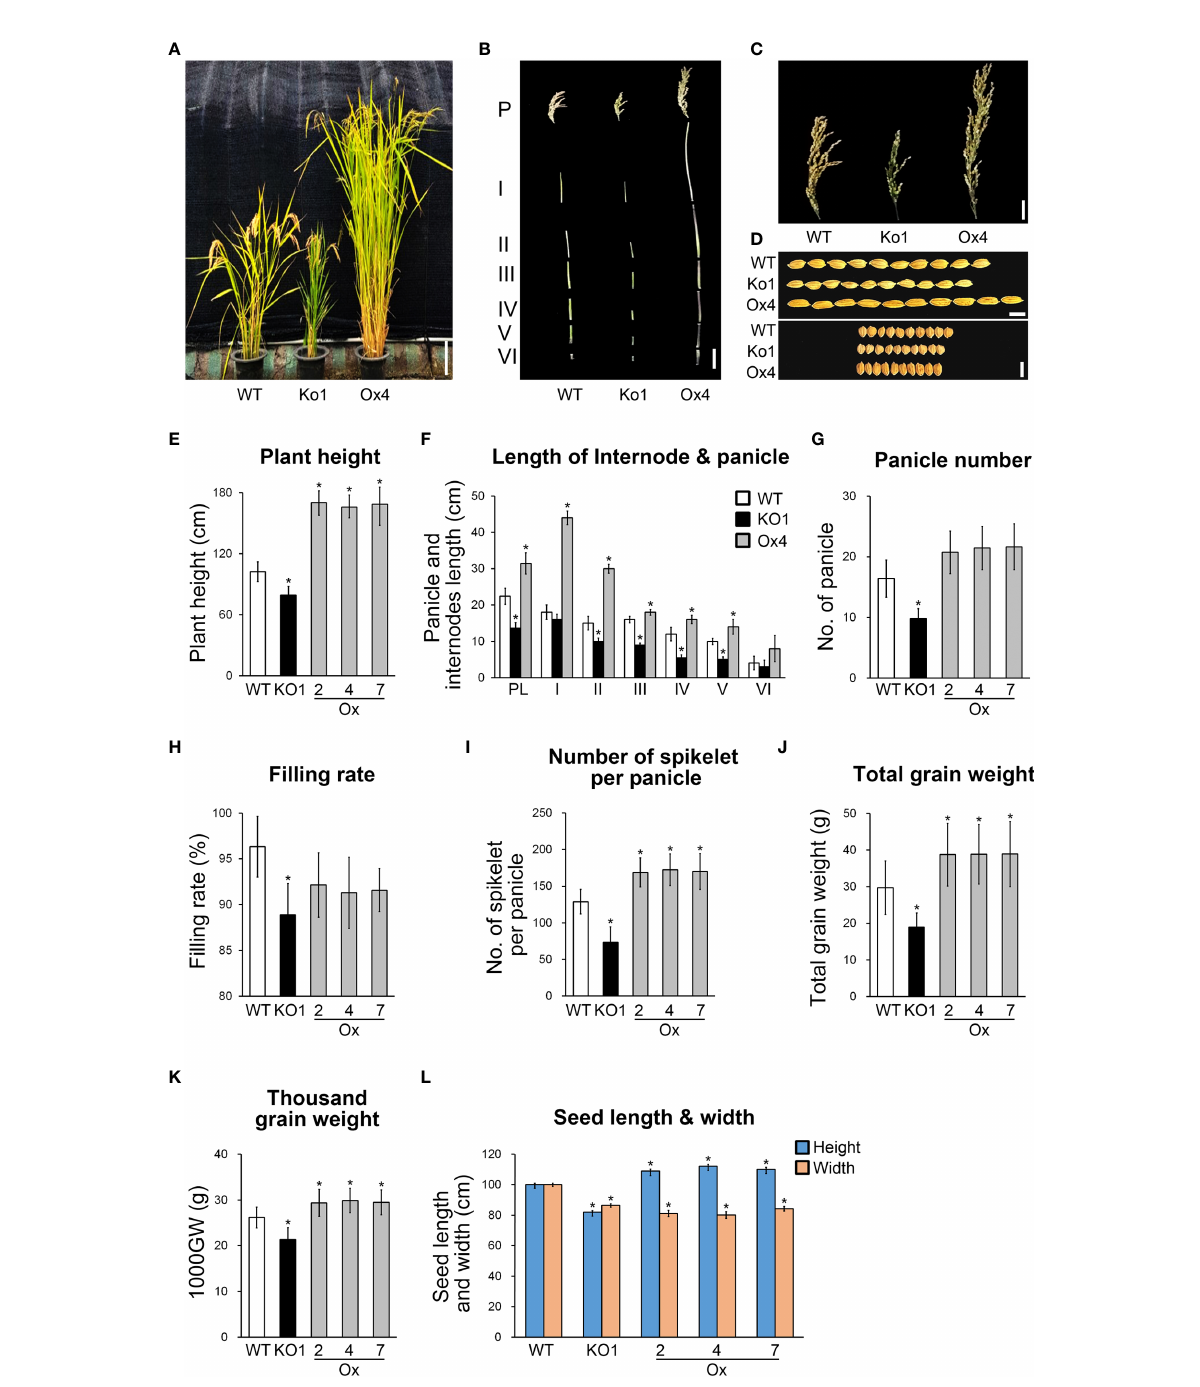
FIGURE 4 Expression of OsGASD affects agronomic traits under normal growth conditions. (A) Morphology of 25-week-old wild-type (WT), osgasd knockout mutant (Ko) and OsGASD-overexpressing (Ox) plants grown in the fi eld. Scale bar = 15 cm (B) Images show the main panicles and internodes. P and PL indicated the panicle and panicle length. I to V indicated the corresponding internodes from top to bottom. Scale bar=10cm. (C) Images show the panicles with grains. The panicles shown were grain from a single main panicle. (D) Images show the size of the grains Ox and Ko indicate OsGASD- overexpressing and mutant plants, respectively. WT indicates wild-type plants. Scale bars = 15 cm in (A) 5cm in (B) , 1cm in 0.2cm in (D) . (E – K) The analysis of agronomic traits of the Ox and Ko plants grown in fi eld. Plant height (E) , internode length and panicle (F) , panicle number (G) , fi lling rate (H) , number of spikelet per panicle (I) , total grain weight (J) and thousand grain weight (K) . (L) analysis of seed length and width of the Ox and Ko plants. Three independent lines of T4 OsGASD-Ox and -Ko plants were analyzed together with their wild-type counterparts grown in the same conditions. The values represent the percentage of the mean values (n = 30) listed in Tables S1. Mean values of WT controls were set at 100% as a reference. Asterisks indicate statistically signi fi cant differences between the corresponding samples and their control (p-value<0.1, Student ’ s